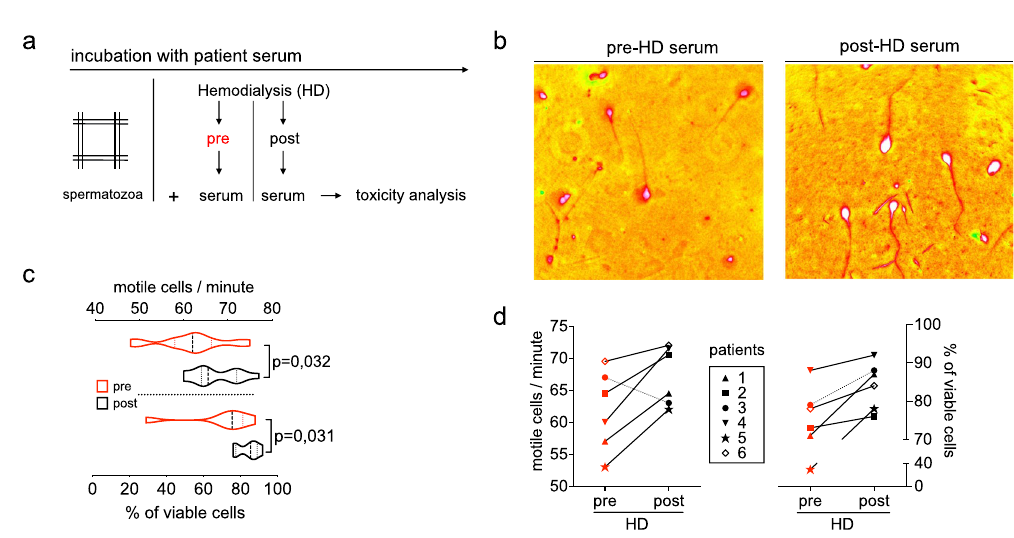
Figure 5. Detection of toxin-removal by hemodialysis. (a) Sera from six hemodialysis (HD) patients were taken pre and post HD. Incubation procedure was performed with human spermatozoa. (b) Staining of one representative experiment. Eosin + dead cells stained red. White cytoplasm indicates viability. (c) Motility counts per minute and viability of cells after 120 minutes of incubation with pre- and post-HD serum, respectively. Violin plots summarize six HD patients measured in two separate experimental runs. (d) Patient-specific outcome on motile function (left) and viability (right). Individual patients (n = six) are displayed separately. For clinical data see Table 2. P-value indicates significance